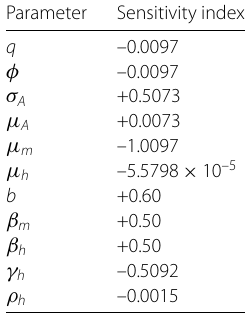
Table 3 Sensitivity indices of R 0 evaluated at the baseline parameter values for α =